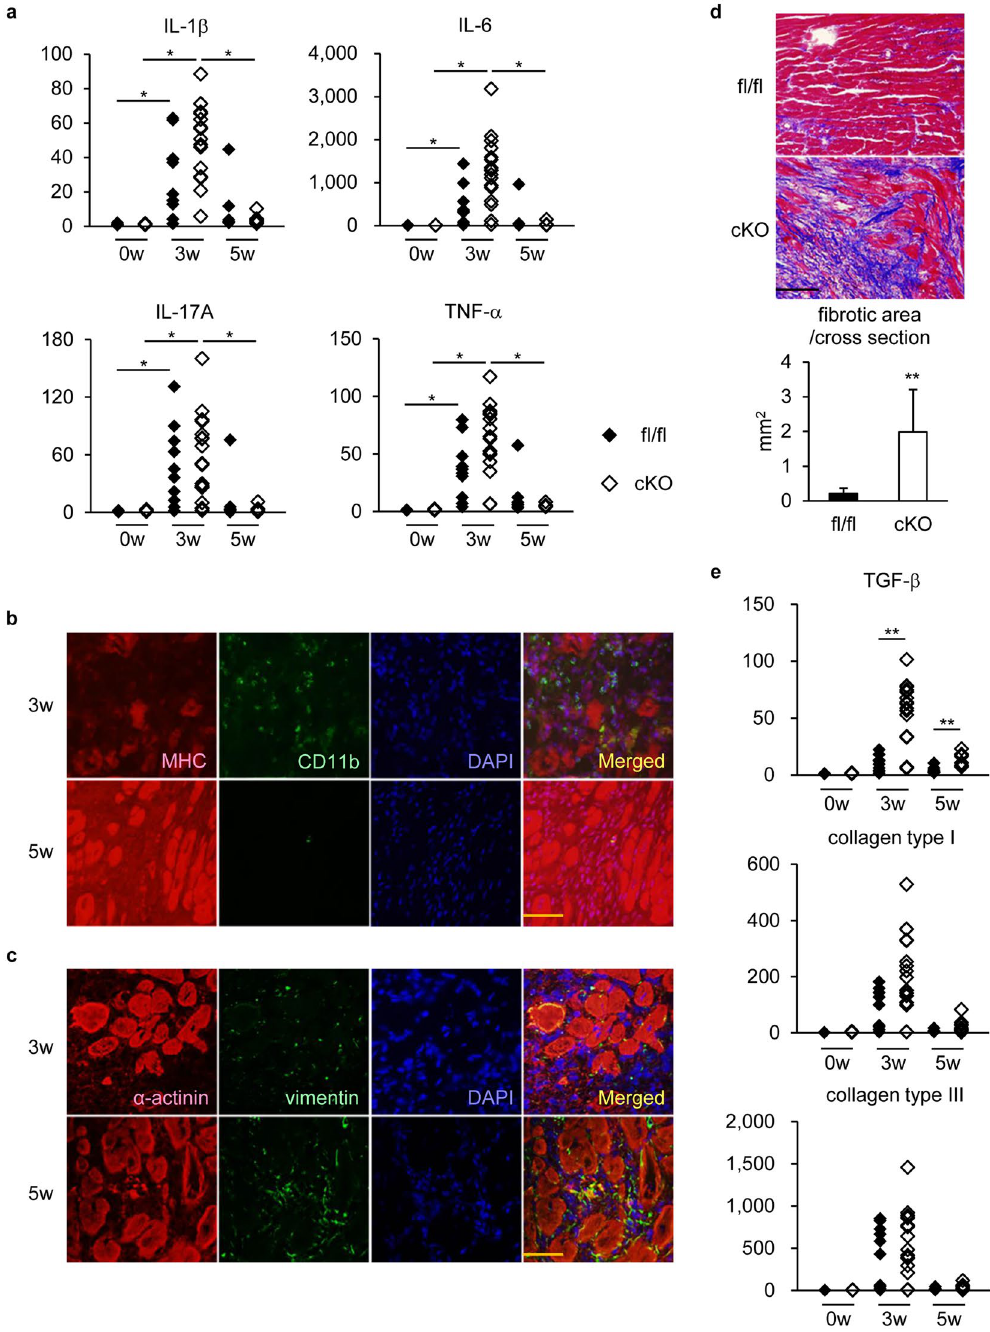
Figure 6. Fibrosis was augmented in STAT3cKO hearts at EAM5w. ( a ) The expression of IL-1 β , IL-6, IL-17A and TNF- α transcripts in STAT3fl/fl and STAT3cKO hearts was quantified at the indicated time points after EAM induction by quantitative RT-PCR. The expression of these genes was normalized to that of gapdh and shown as fold increase relative to fl/fl 0w. n = 5 mice for fl/fl 0w and cKO 0w; 10 mice for fl/fl 3w; 16 mice for cKO 3w; 7 mice for fl/fl 5w; 8 mice for cKO 5w. ( b ) Heart sections from STAT3cKO mice at EAM3w and EAM5w were immunostained for MHC and CD11b. Scale bar: 50 μ m. ( c ) Heart sections from STAT3cKO mice at EAM3w and EAM5w were immunostained for α -actinin and vimentin. Scale bar: 50 μ m. ( d ) Masson’s trichrome staining was performed for heart sections from STAT3fl/fl and STAT3cKO mice at EAM5w. Top: representative images are shown. Scale bar: 100 μ m. Bottom: fibrotic area was measured. Data were from 7 mice for each group. ( e ) The expression of TGF- β , collagen type I and collagen type III transcripts in STAT3fl/fl and STAT3cKO hearts was quantified at the indicated time points after EAM induction by quantitative RT-PCR. The expression of these genes was normalized to that of gapdh and shown as fold increase relative to fl/fl 0w. n = 5 mice for fl/fl 0w and cKO 0w; 10 mice for fl/fl 3w; 16 mice for cKO 3w; 7 mice for fl/fl 5w; 8 mice for cKO 5w. ( a , e ) Steel-Dwass test; ( d ) Welch’s t -test. * P < 0.05, ** P < 0.01. Data are shown as mean ± s.d. in ( d